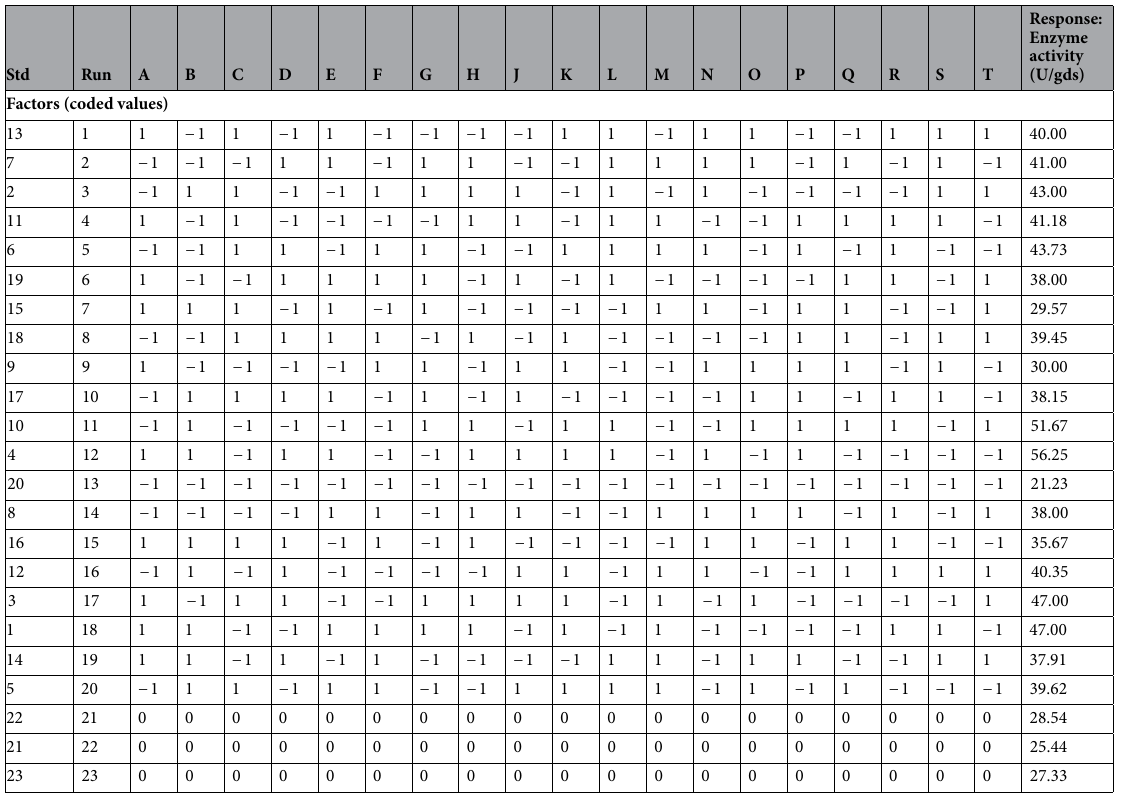
Table 3. Nutrient contributions to pullulanase production by Placket-Burman design matrix (randomized). Symbols used: A-peptone; B-Yeast extract; C-NH 4 SO 4 ,; D-urea; E-KH 2 PO 4 ; F-Na 2 CO 3 ; G-CuSO 4 ; H-FeSO 4